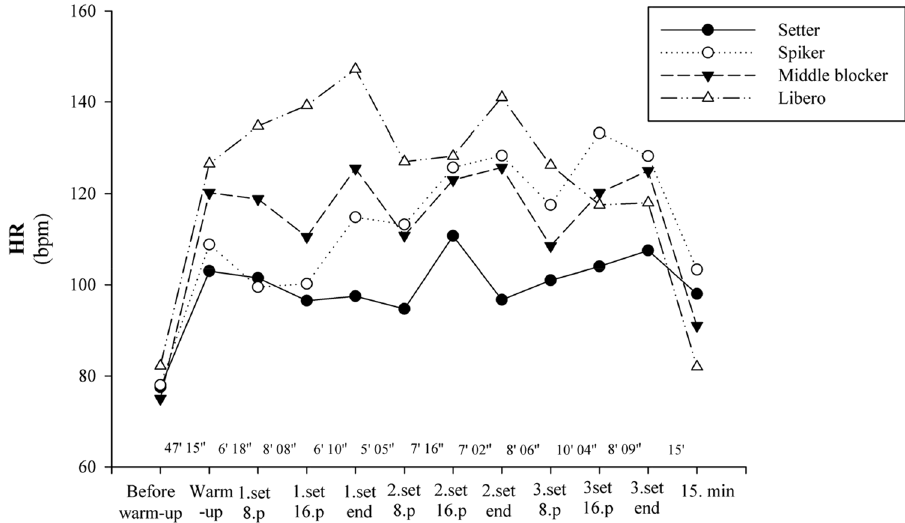
Figure 2. HRs according to playing positions before, during and after volleyball match.